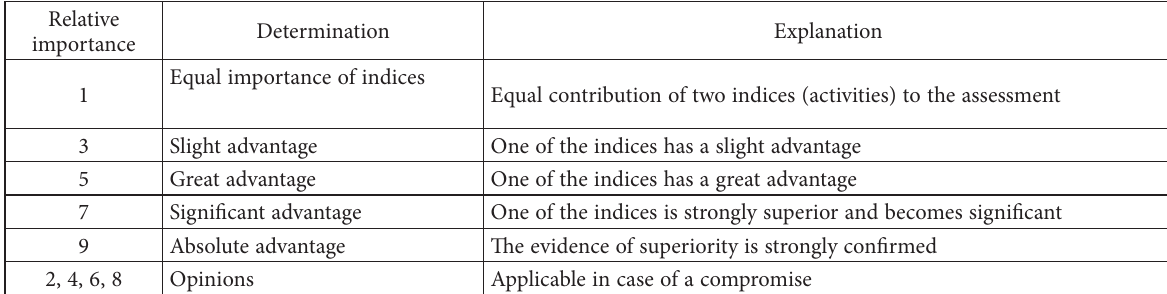
Table 2. Comparison scale of alternatives Relative importance